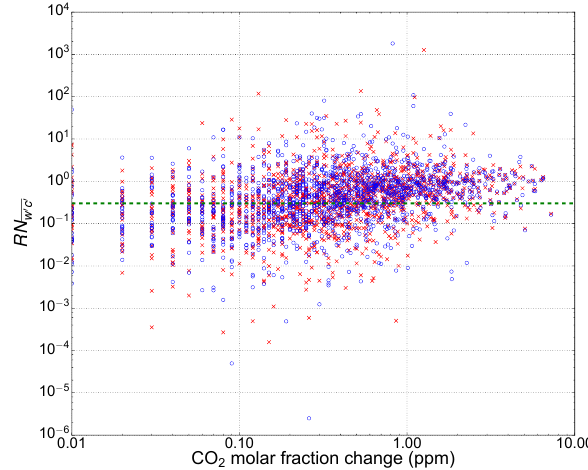
Figure 6. Relative nonstationarity of CO 2 flux as a function of the absolute change in CO 2 concentration during the averaging period: standard (red cross) and test (blue circle) setups. The green dashed = 0 . line indicates the limit of RN w (cid:48) c (cid:48)